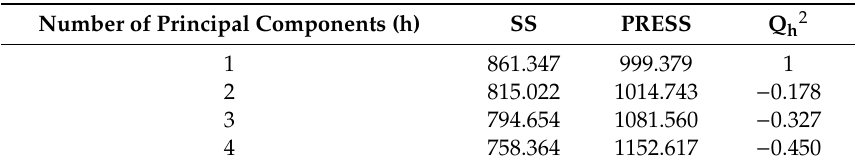
Table 4. Cross-validity